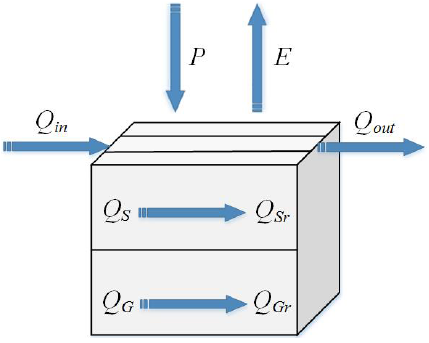
Figure 9. The water exchange processes in a channel grid cell.